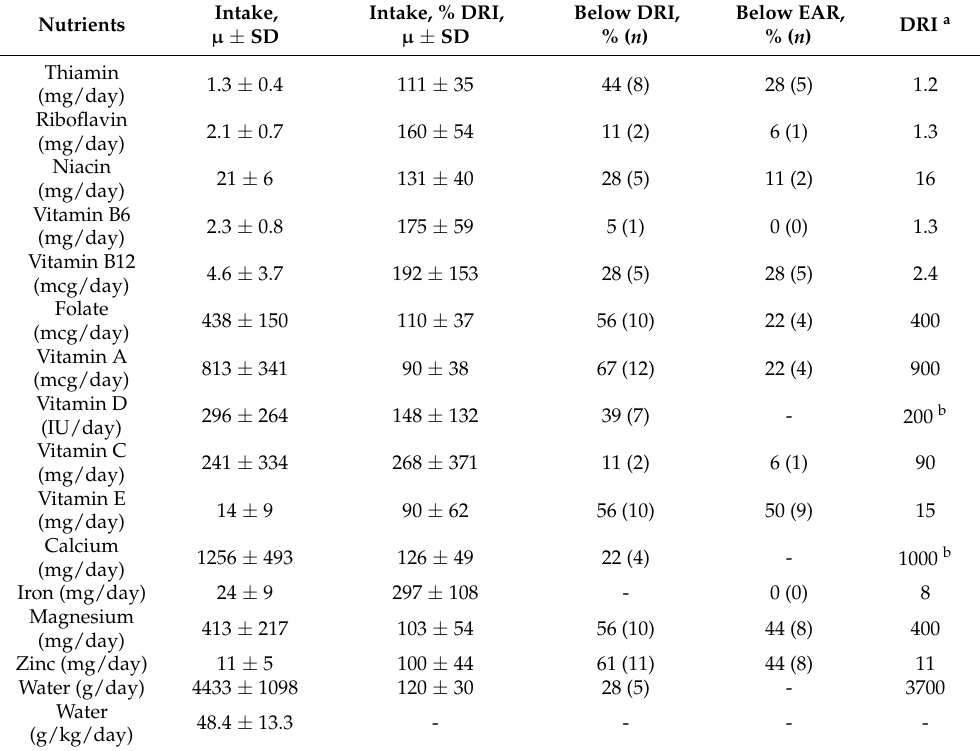
Table 3. Micronutrient intake of players compared to DRI values ( n =